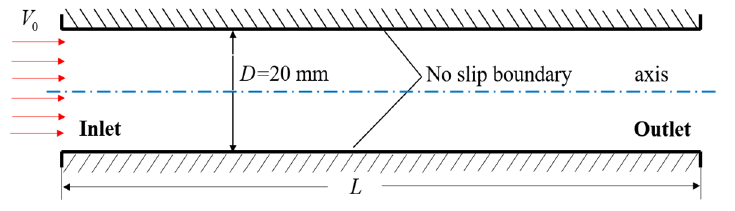
Figure 5. The schematic of the smooth circular tube.